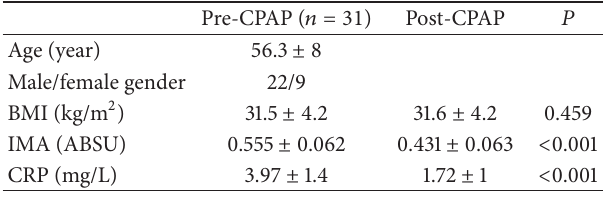
Table 2: Independent predictors of obstructive sleep apnoea syn- drome in multivariate logistic regression analysis.